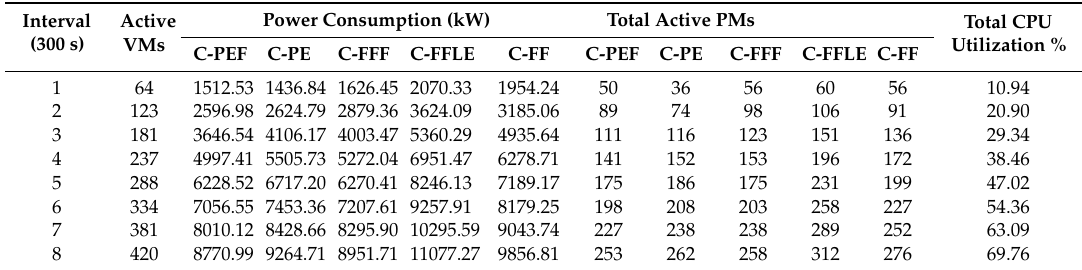
Table 5. Power consumption for 100% ratio of VM acceptance